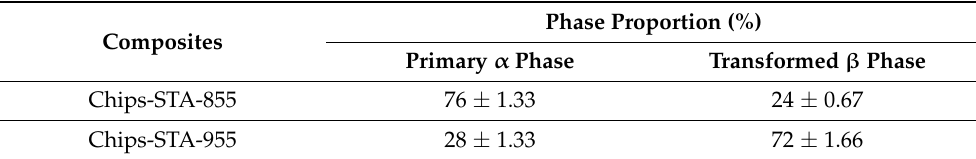
Table 4. Phase proportion of Chips-STA-855 and Chips-STA-955